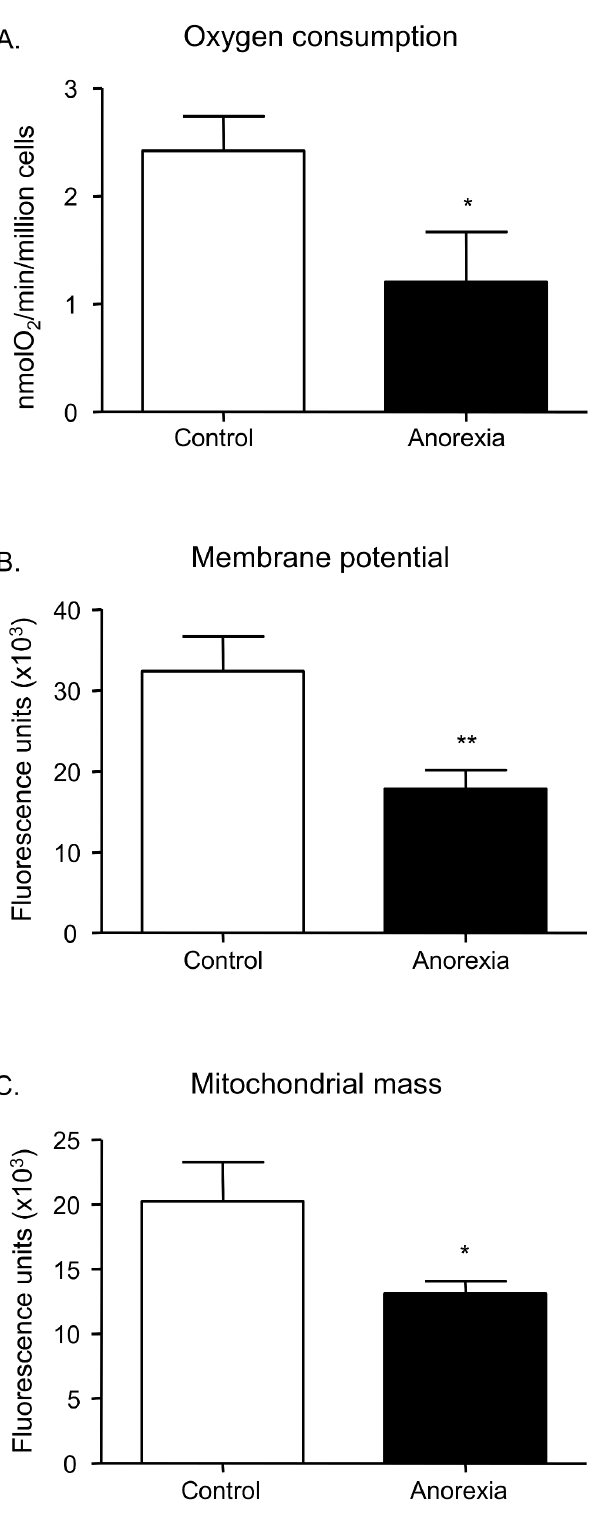
Figure 1. Effect of anorexia on O 2 consumption (A) rate, measured as nmol O 2 /min/million cells, on membrane poten- tial (B), measured by TMRM fluorescence, and on mitochon- drial mass (C), measured by NAO fluorescence. n=20 per group. *P , 0.05 and **P , 0.01 vs. control.